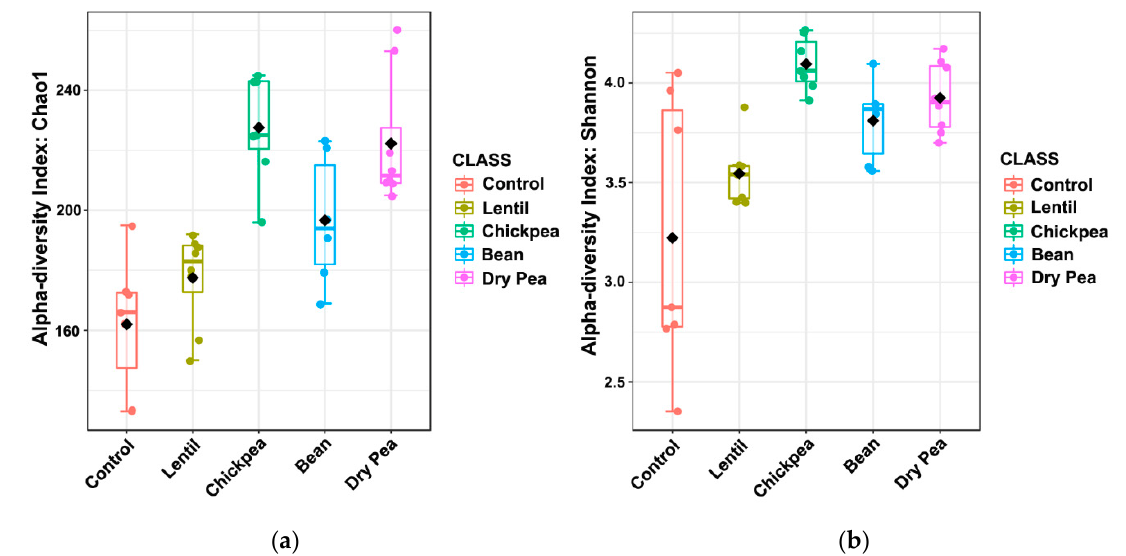
Figure 3. The boxplots of α -diversity metrics of the cecal microbiota across diet groups at the ASVs level: ( a ) α -diversity measured with the Chao1 index indicating differences in richness; Kruskal-Wallis test statistic = 24.501, p -value = 6.338 × 10 − 5 ; ( b ) α -diversity measured with the Shannon index accounting for differences in richness and evenness; Kruskal-Wallis test statistic = 18.41, p -value = 1.026 × 10 − 3 .